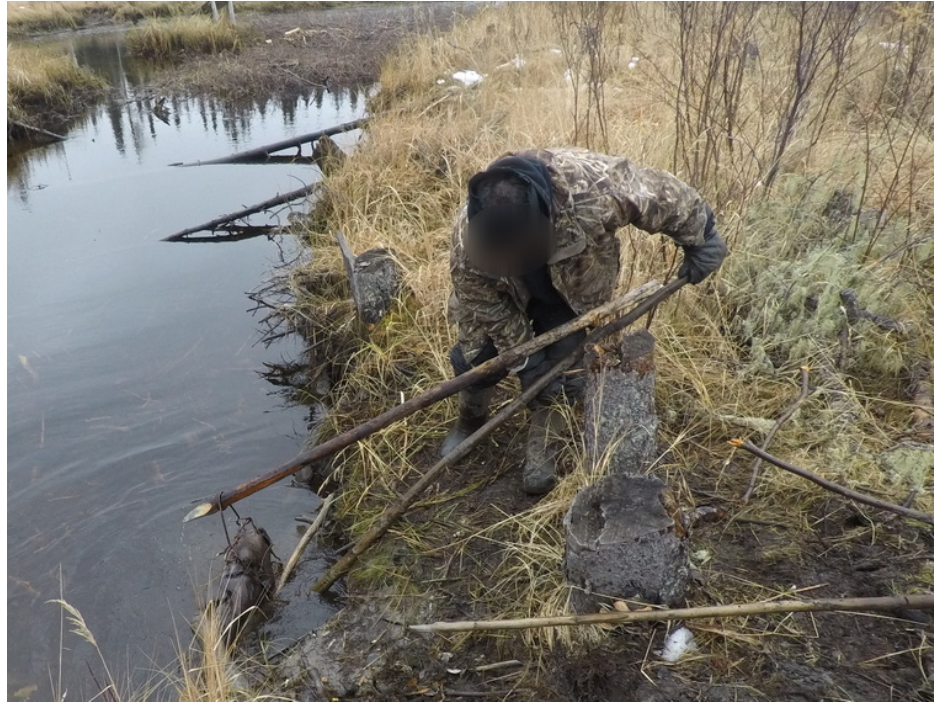
Figure 10. An on-the-land expert removing a beaver which was caught using a conibear trap. It was evident through the discussions that the land was central to the health and well-being of the participants. The land was a source of resilience, but also a way to re- connect with ancestors and provide for the future generations. Through their participation in this program, individuals furthered their cultural continuity, allowing for the healing of the land and themselves.